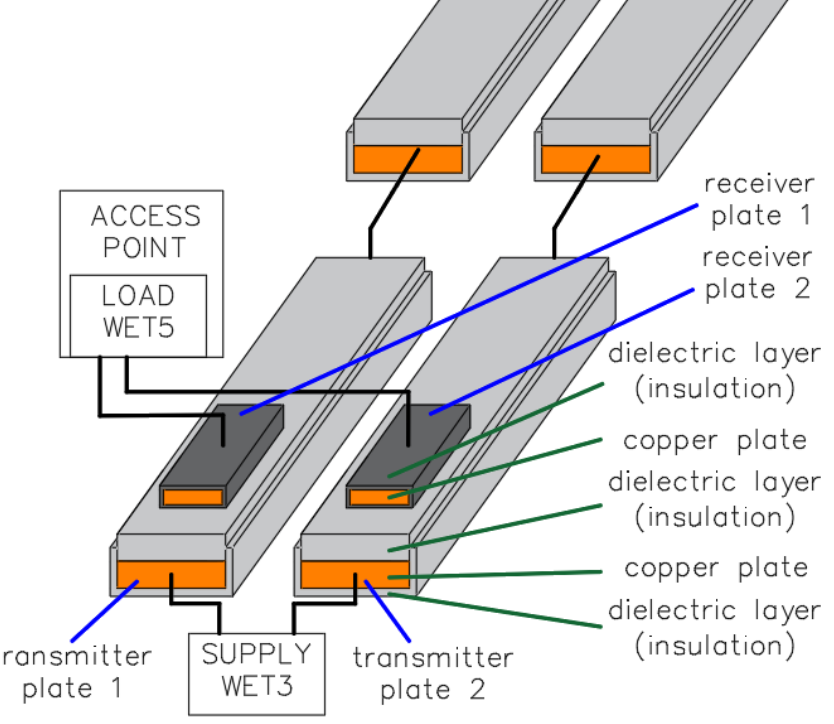
Figure 5. Capacitive coupling—a key component of a wireless energy transfer system.